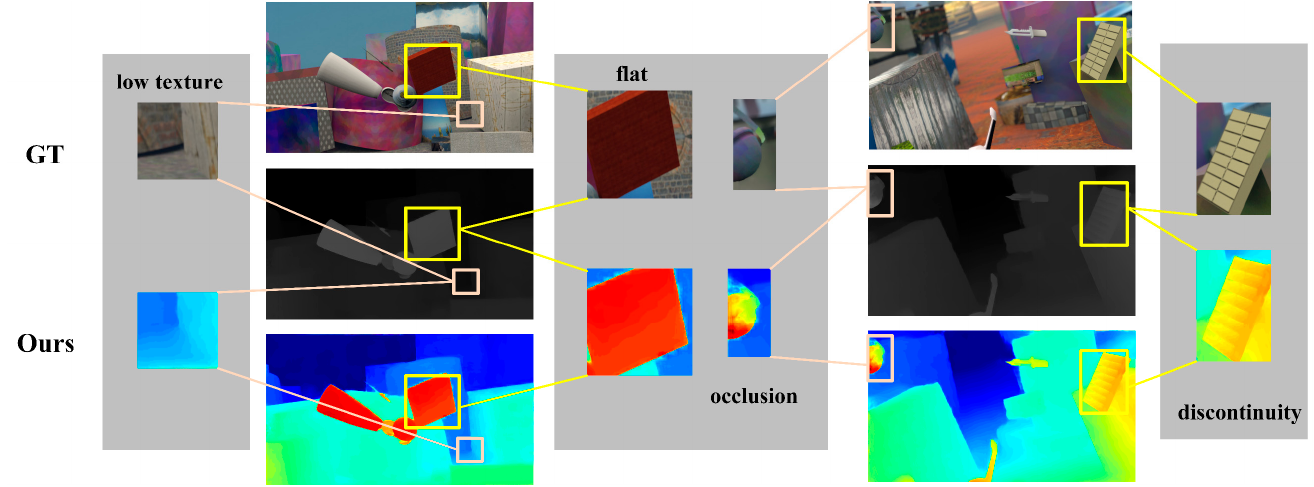
Figure 10. The results for discontinuity, flat, occlusion, and low texture regions on Scene Flow.